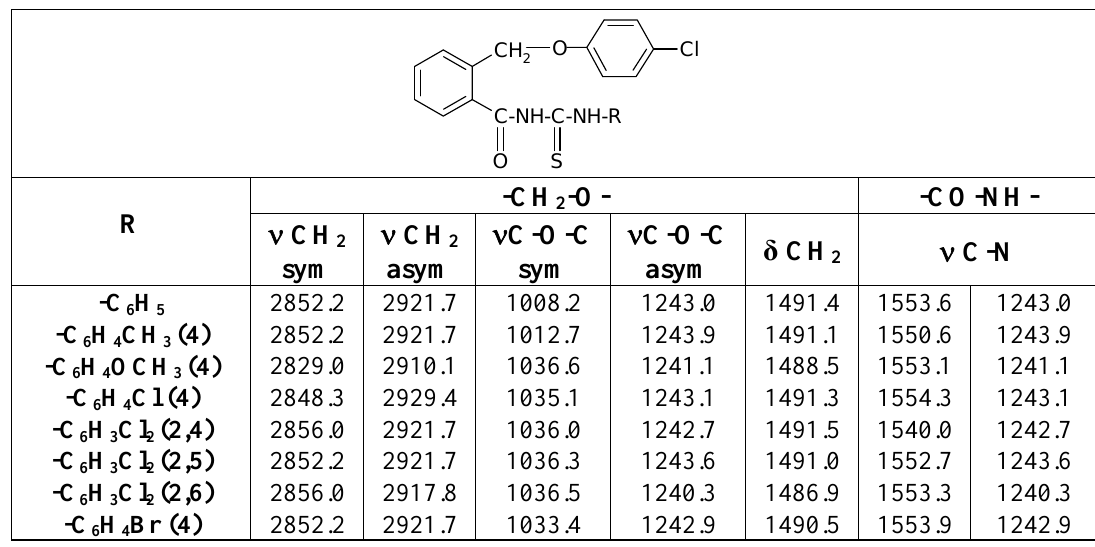
Table 5. IR data for the new